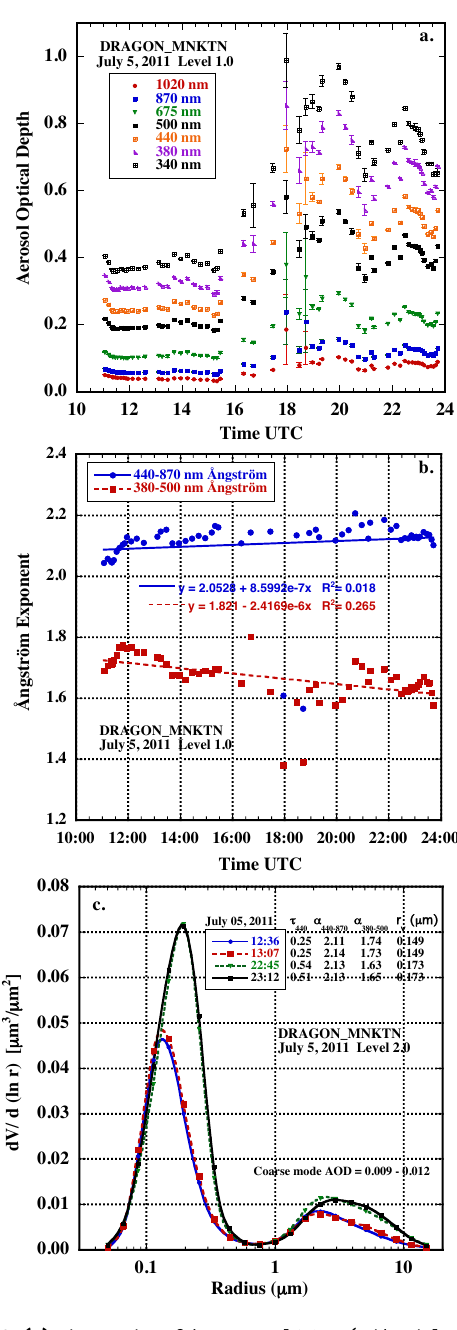
Figure 6. (a) Time series of the spectral AOD (with triplets shown) at the DRAGON_MNKTN site on 5 July 2011 (see Fig. 5 for the fine and coarse mode time series). (b) Time series of the Ångström exponent for two wavelength intervals for the same data set. (c) Vol- ume size distribution retrievals made in early morning and late af- ternoon, both before and after cumulus cloud formation and then